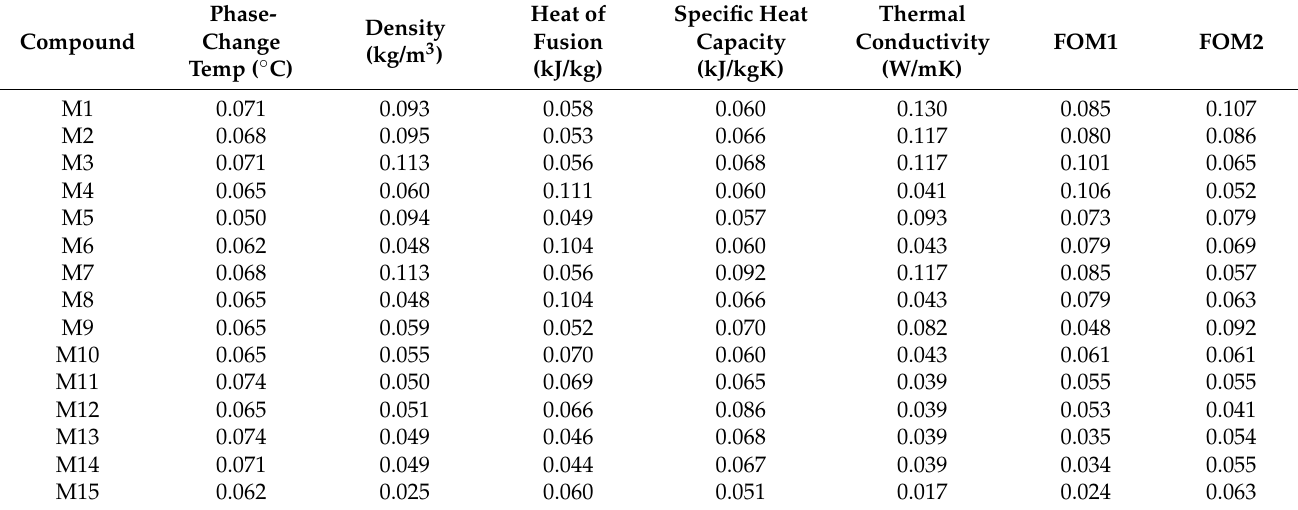
Table 16. COPRAS normalized